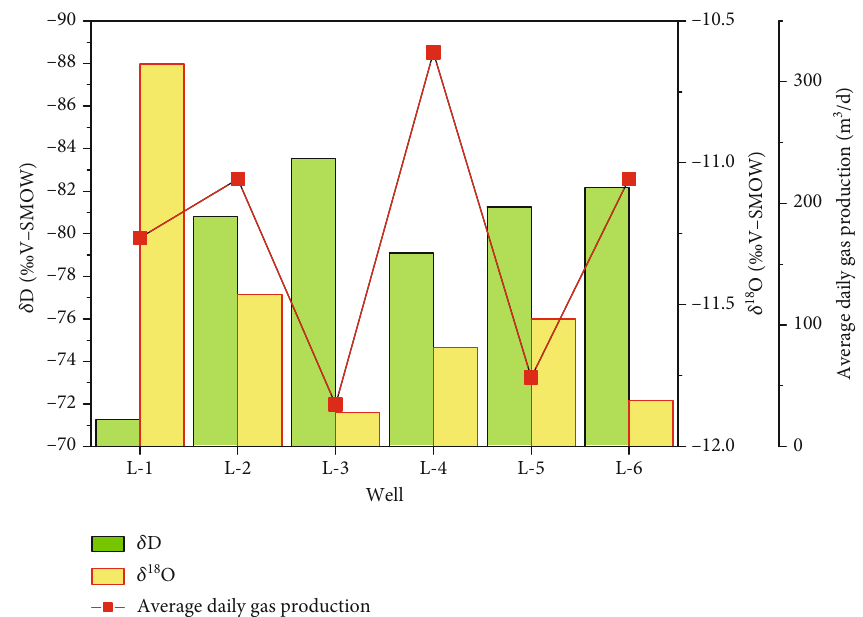
Figure 6: The relationship between δ D and δ 18 O isotopes and gas production in produced water.